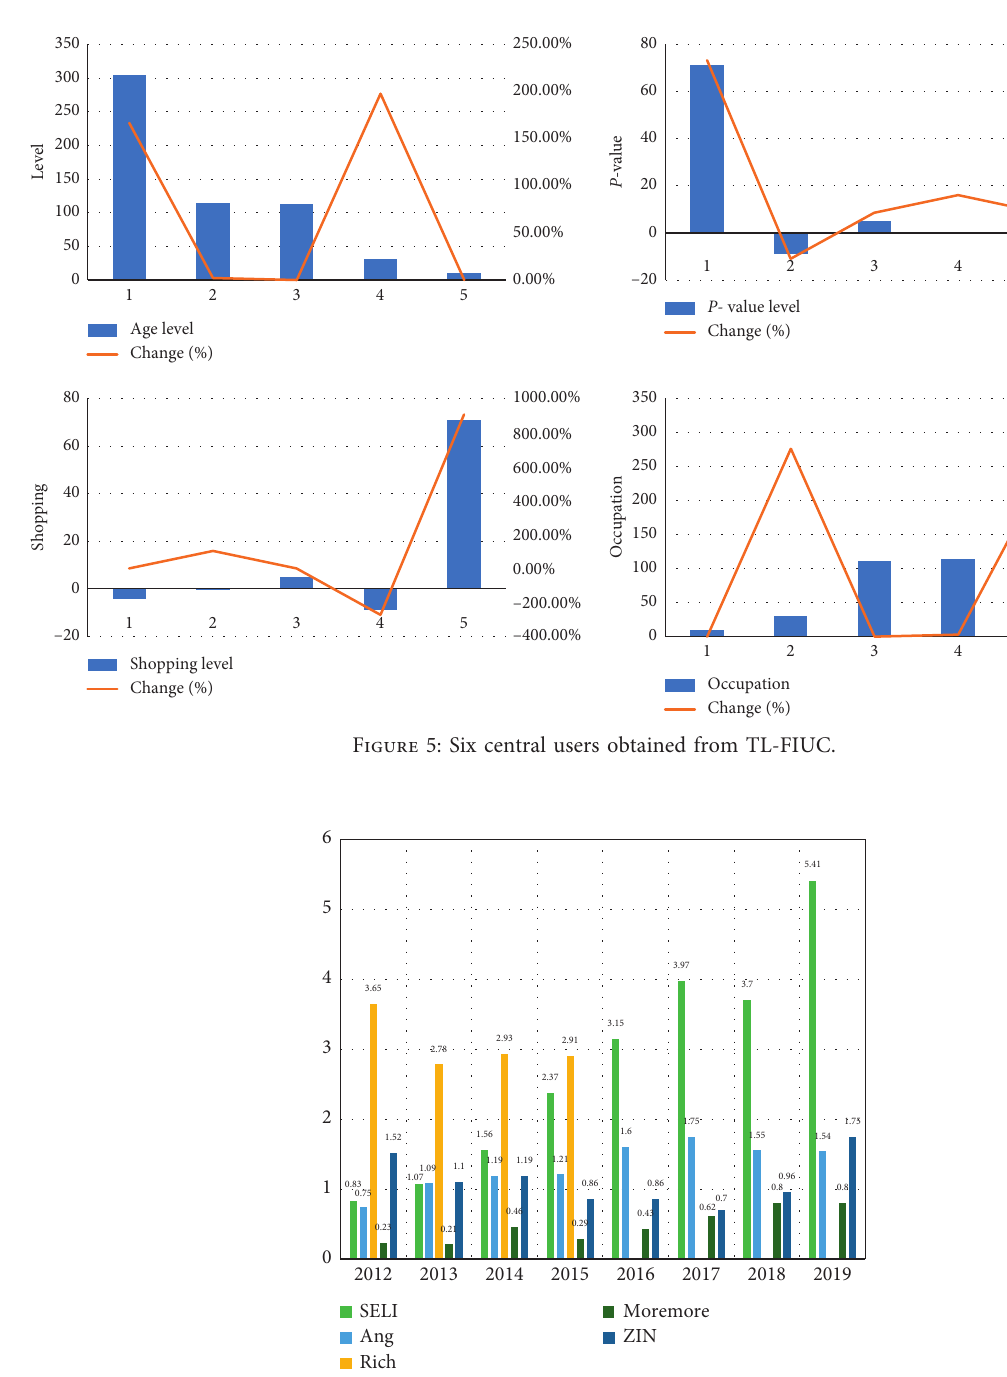
Figure 6: Performance of FMI indicators for clustering results under numerical